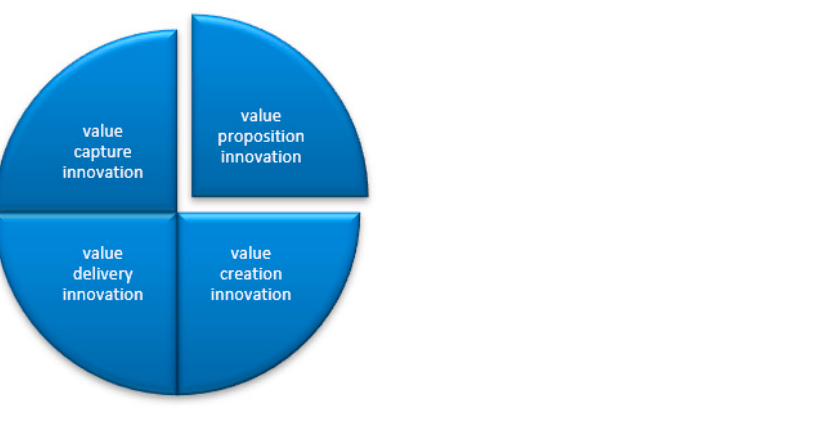
Figure 2. Business model innovation components. The figure was created using Microsoft ® Word for Microsoft 365 MSO.